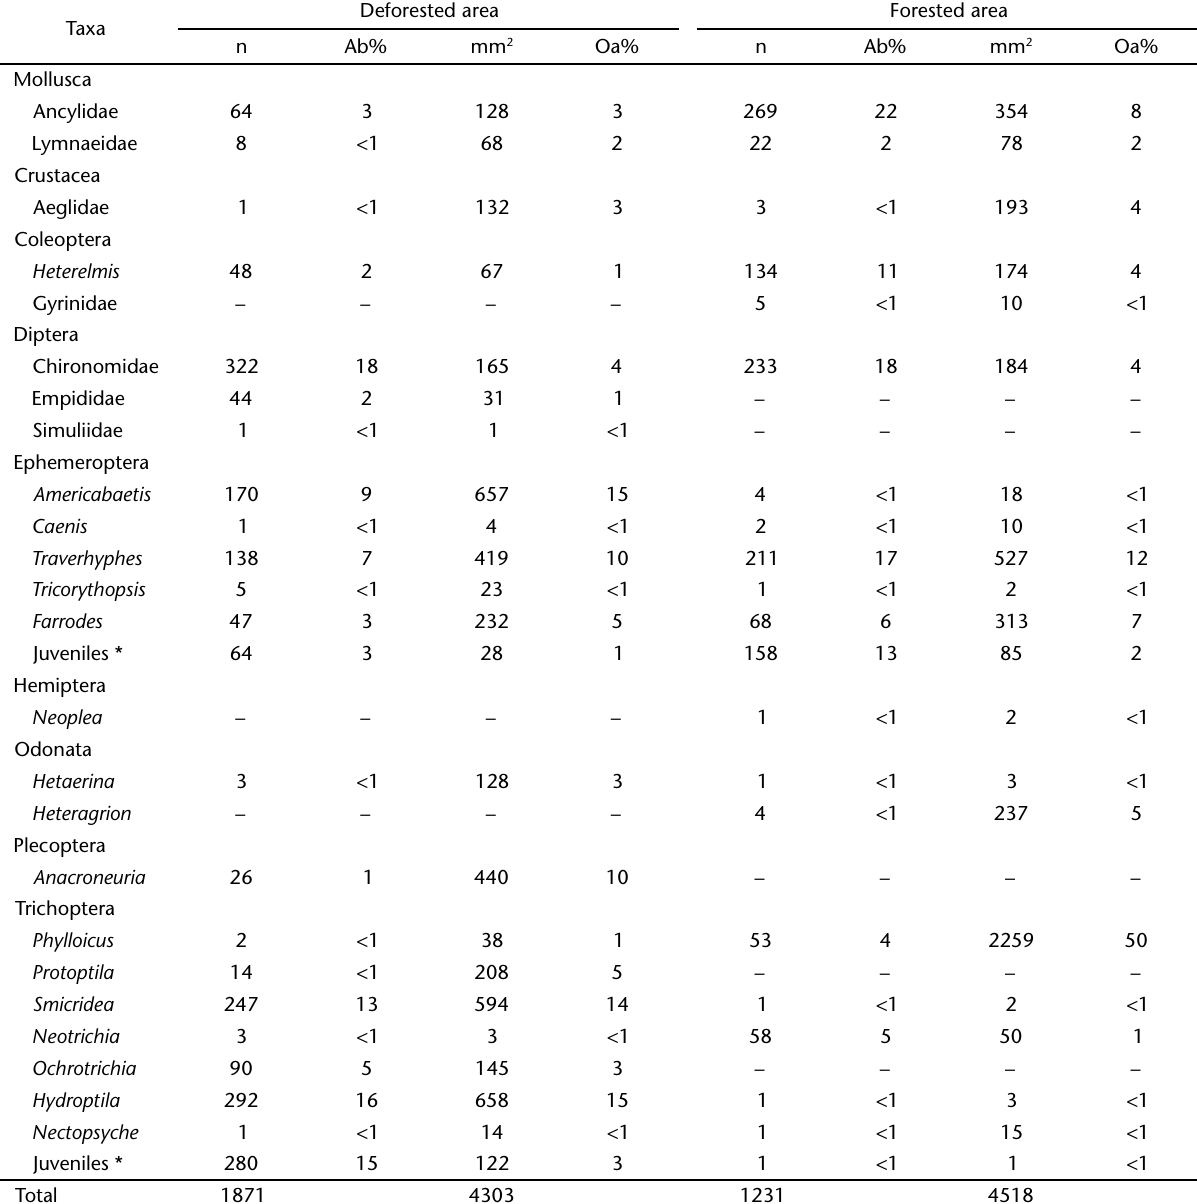
Table III. Macroinvertebrates sampled in leaf-bags incubated in two areas of the Ribeirão da Quinta stream during the rainy season (December 2004). Absolute (n) and relative (Ab%) abundance, absolute (mm 2 ) and relative (Oa%) occupied